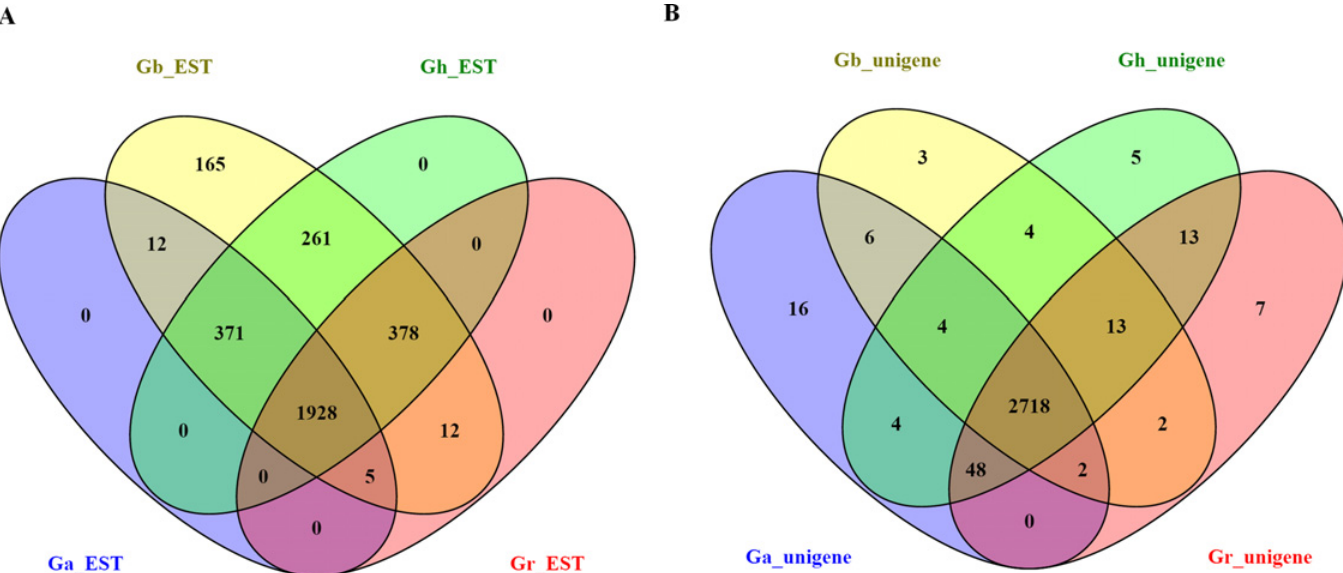
Fig 2. The distribution of uniESTs in four reference cotton species obtained using four different cotton species EST databases and unigenes from different cotton subspecies genome databases. Venn diagrams showing the uniESTs in each of the four different cotton species EST databases (A) or unigenes from different cotton subspecies genome databases (B), with the overlapping regions corresponding to the number of uniESTs present in more than one species. The central region corresponds to the uniESTs present in all four species.